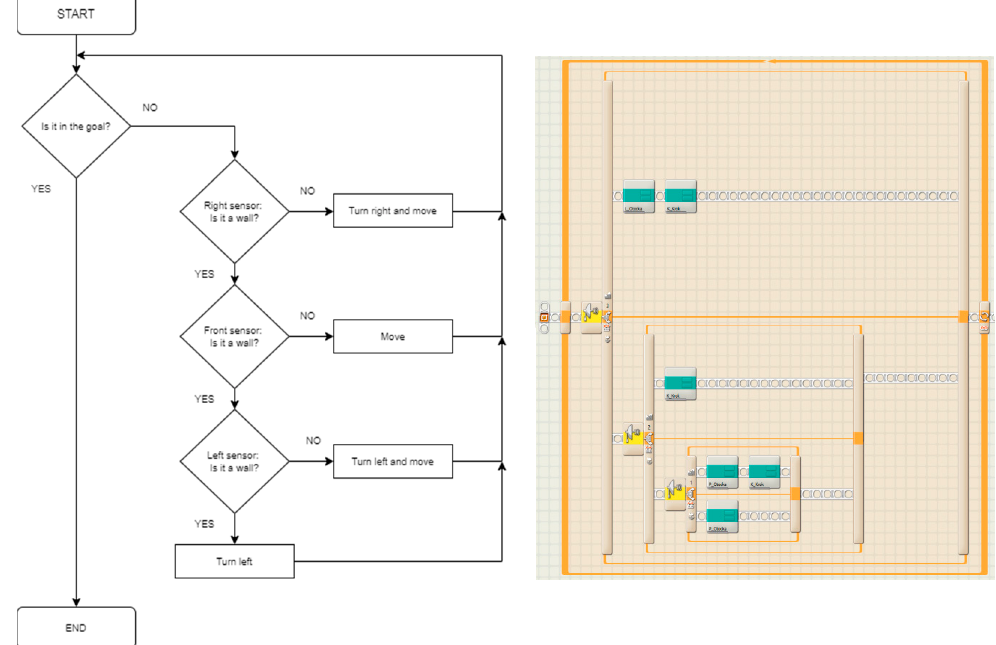
Figure 3. Right wall monitoring flowchart and left wall monitoring implementation in a visual programming environment, Lego Mindstorms NXT.